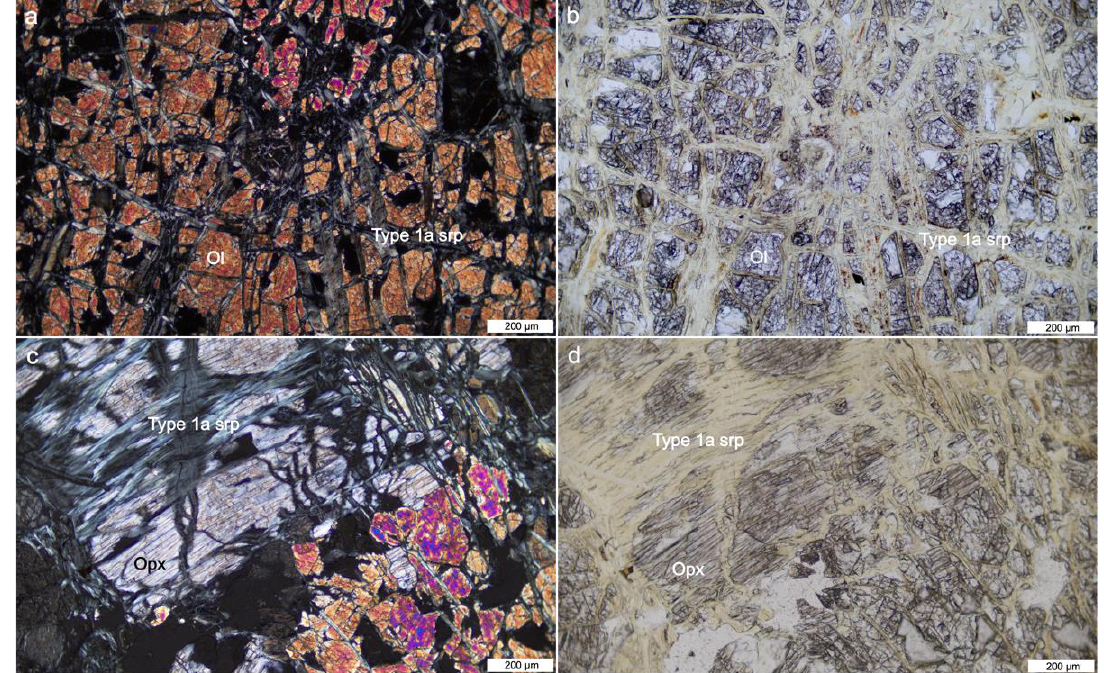
Figure 6. Photomicrographs of the least altered rock in the profile investigated. ( a ) Olivine (Ol) cut by crosscutting serpentine (type 1a) in transmitted plane-polarized light and ( b ) in crossed-polarized light. ( c ) Pyroxene (Opx) is also partially serpentinized parallel to its cleavage planes, in transmitted plane-polarized light. ( d ) Same as ( c ) in crossed-polarized transmitted light.